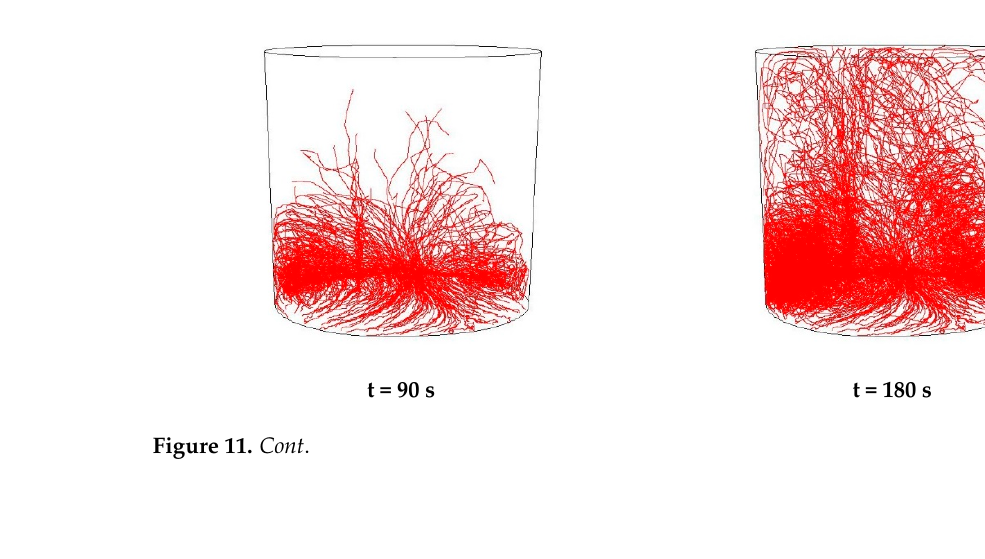
Figure 10. Trajectories of non-metallic MnS inclusions for the case of argon flow of 50 L/min for the particle diameters of ( a ) 18 µm and ( b ) 27 µm in the 18CrNiMo7-6 steel.